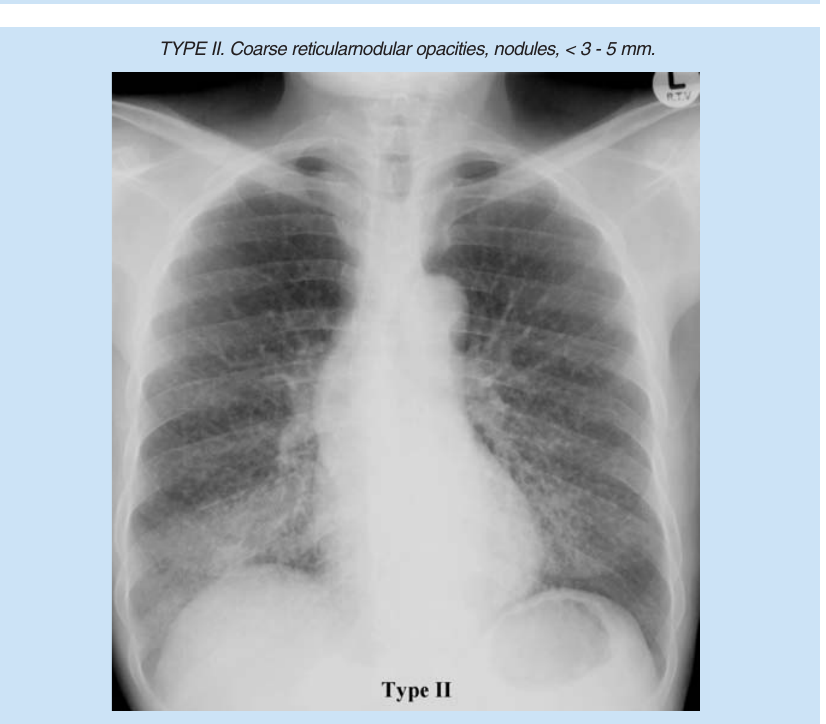
Fig. 3. Twenty-five-year-old female patient, presented with dysphagia due to oral candidiasis. She was on anti-TB treatment for 2 months. No respiratory